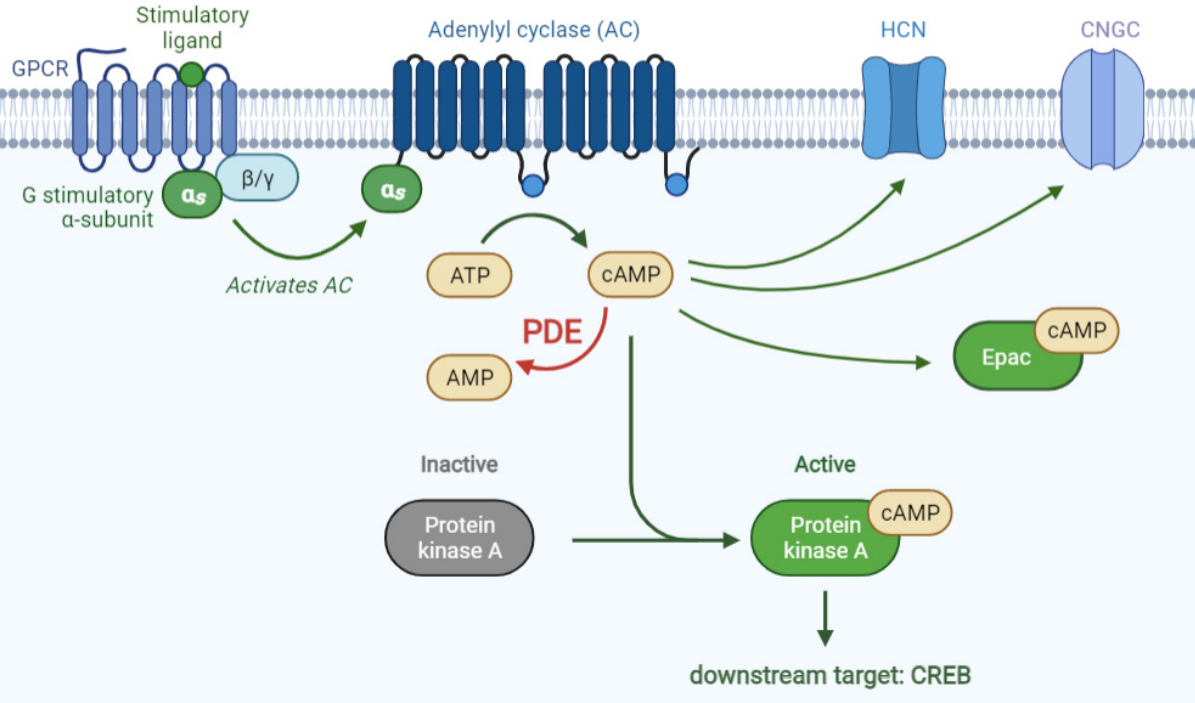
Figure 3. cAMP signaling pathway. Upon binding of a stimulatory ligand to a G-protein coupled receptor (GPCR), adenylyl cyclase (AC) is activated, subsequently stimulating the conversion of ATP to cAMP. cAMP can then activate its downstream targets including protein kinase A (PKA), hyperpolarization-activated cyclic nucleotide regulated channel (HCN), cyclic nucleotide-gated channel (CNGC), and exchange factor directly activated by cAMP (Epac). Activated PKA on its turn activates its downstream target cAMP response element bound protein (CREB). cAMP-specific phosphodiesterases (PDEs) catalyze cAMP to AMP. Figure created with biorender.com (accessed on 1 May 2021).